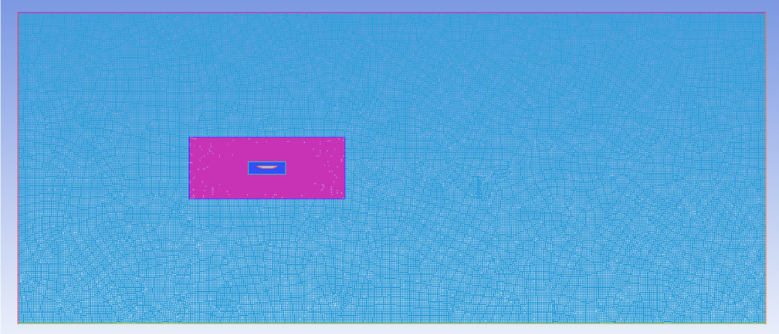
Figure 8. The computational domain grid.